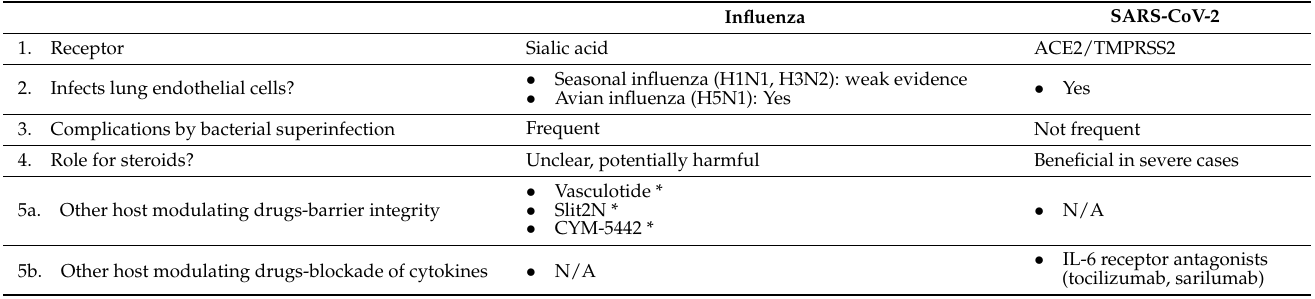
Table 2. Summary of key comparisons between influenza and